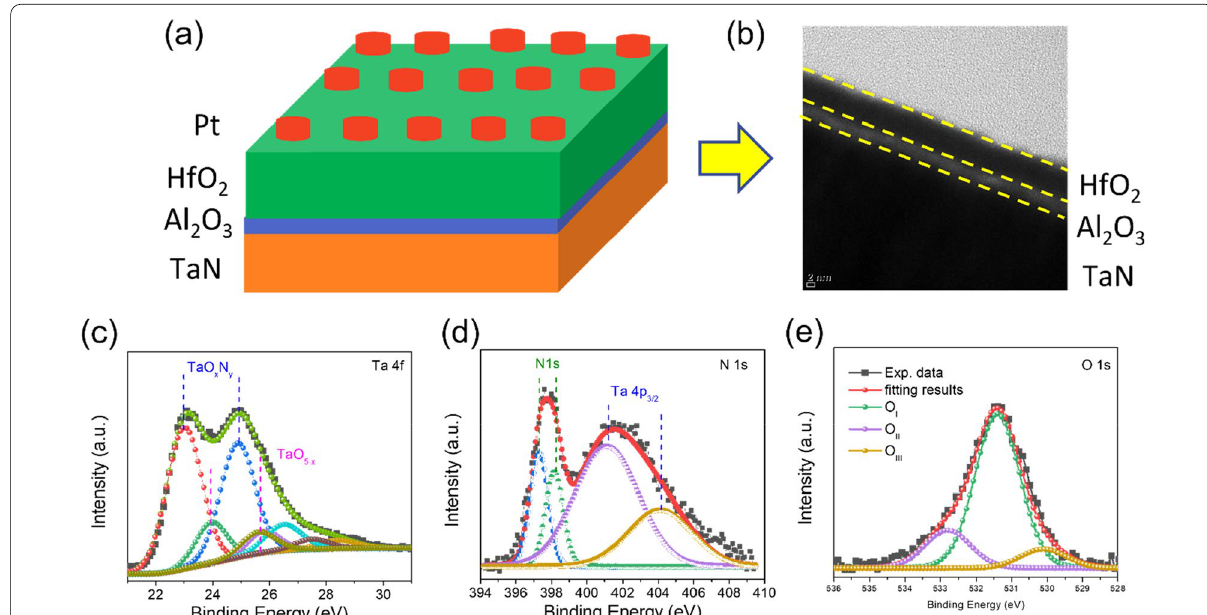
Fig. 1 a Schematic diagram of Pt/HfO 2 /Al 2 O 3 /TaN memristive device. b Cross-sectional TEM image of HfO 2 /Al 2 O 3 /TaN structure. XPS analyses of TaO x N y interfacial layer; c Ta 4f, d N 1s, e O